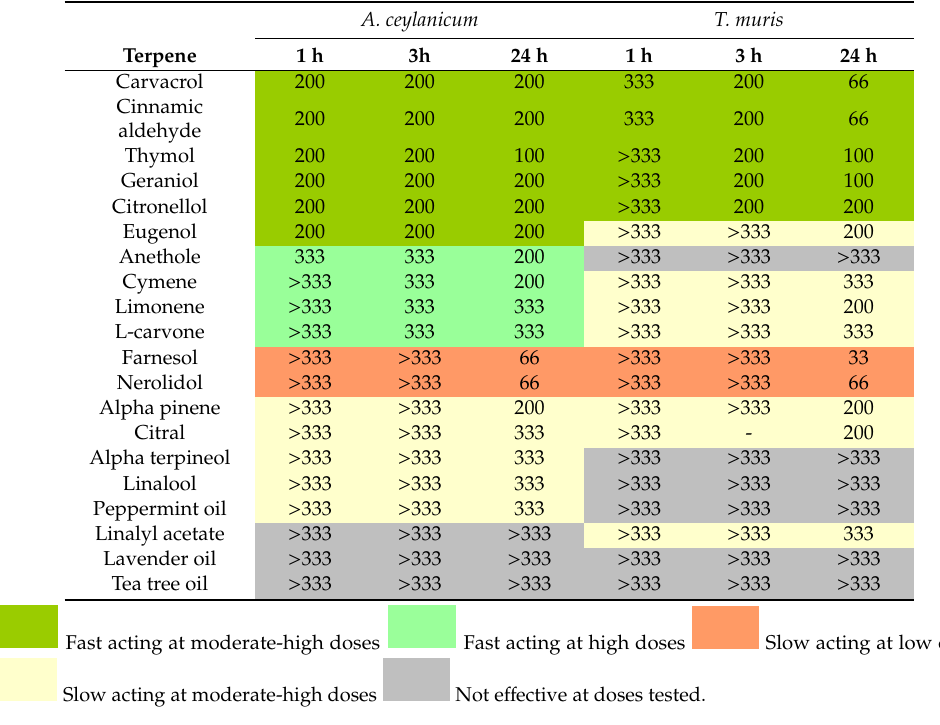
Table 1. Minimum e ff ective doses and classification of YP–terpenes against A. ceylanicum and T. muris .